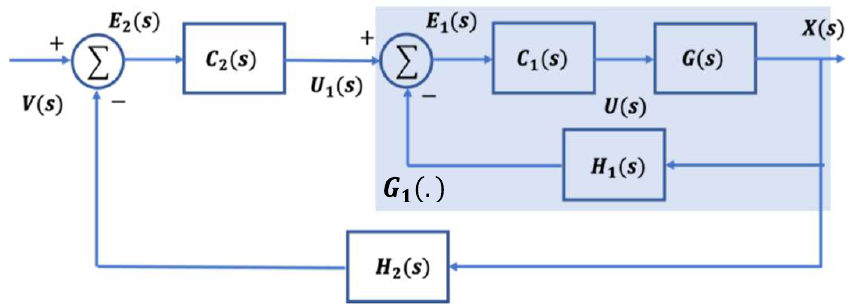
Figure A3. Transform and Control Architecture